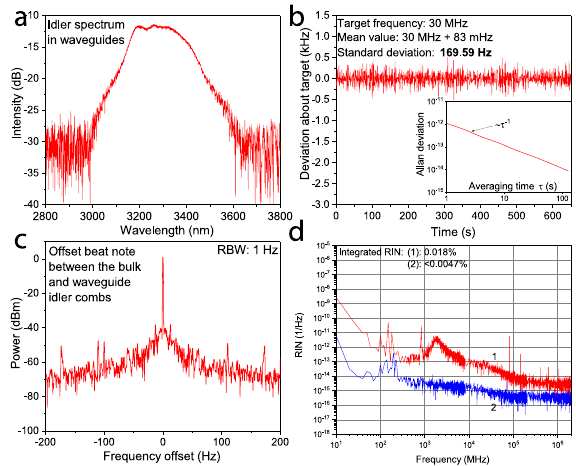
Fig. 2. (a) Typical idler spectrum in waveguides; (b) Relative Intensity Noise (RIN): (1) saturated OPG in bulk crystal with CW seeding; (2) same as (1) but in waveguides; (c) Offset beat note between the bulk and waveguide idler combs (pump laser is the same for both combs, see [5] for details); (d) Frequency counting experiment of the offset beat note in